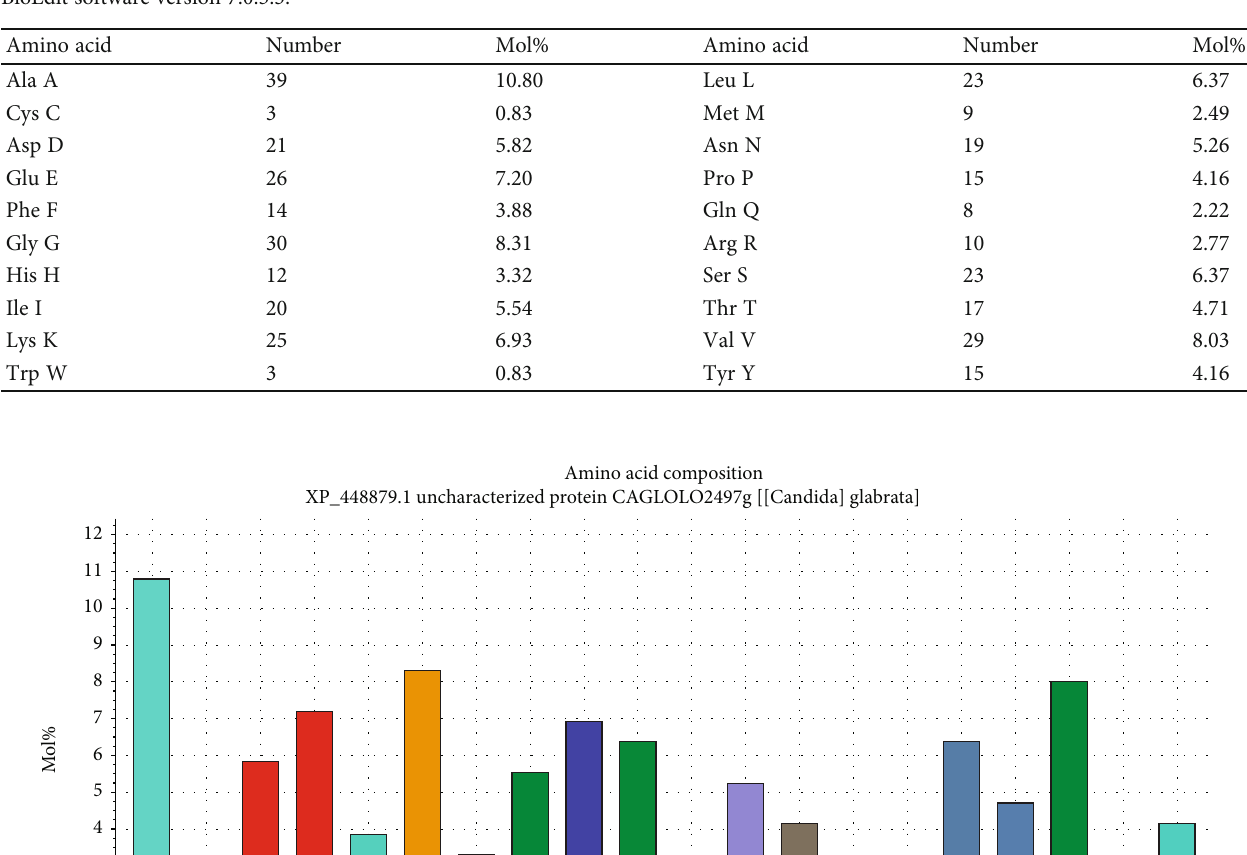
Table 6: Amino acid composition of the protein (fructose bisphosphate aldolase) with their number and molecular weight (Mol%) using BioEdit software version 7.0.5.3.